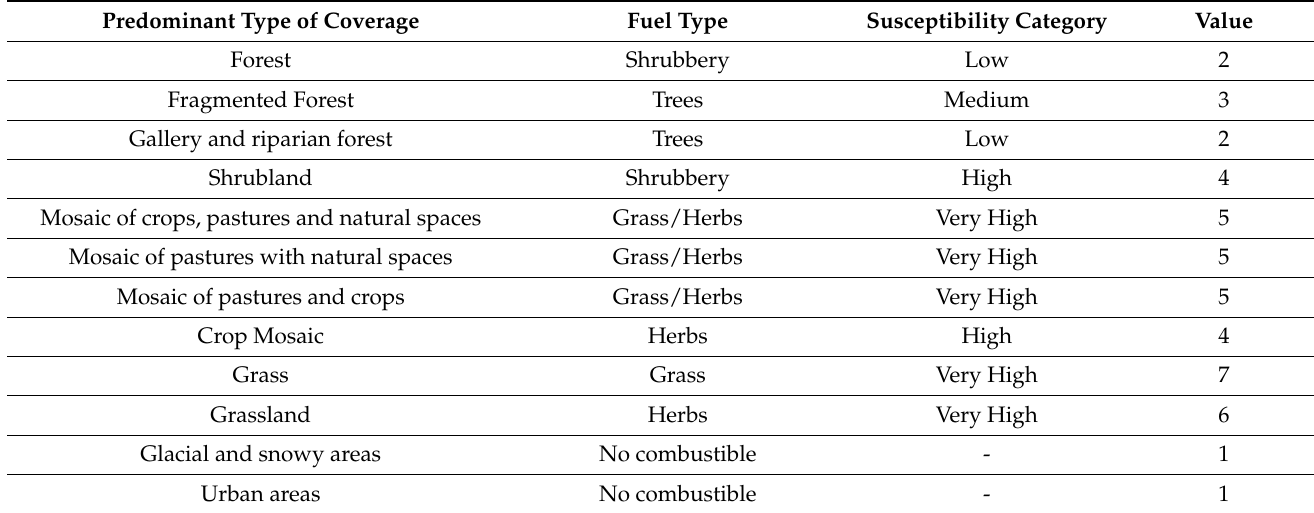
Table 1. Coverage classification and fuel